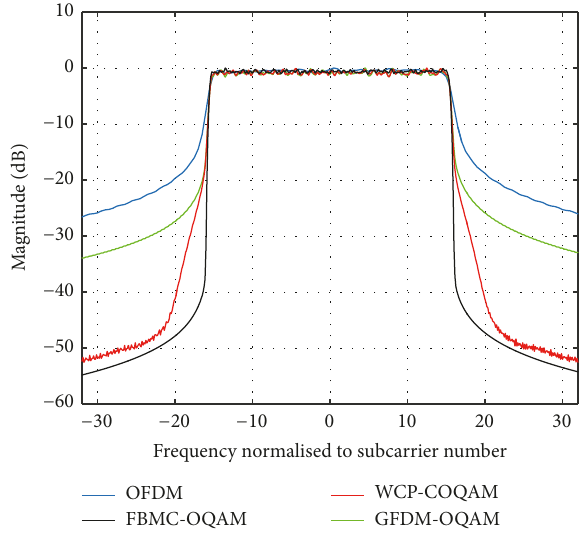
Figure 11: PSD of the analysed MCM systems with some subcarriers deactivated. Only the central 32 subcarriers out of 512 are